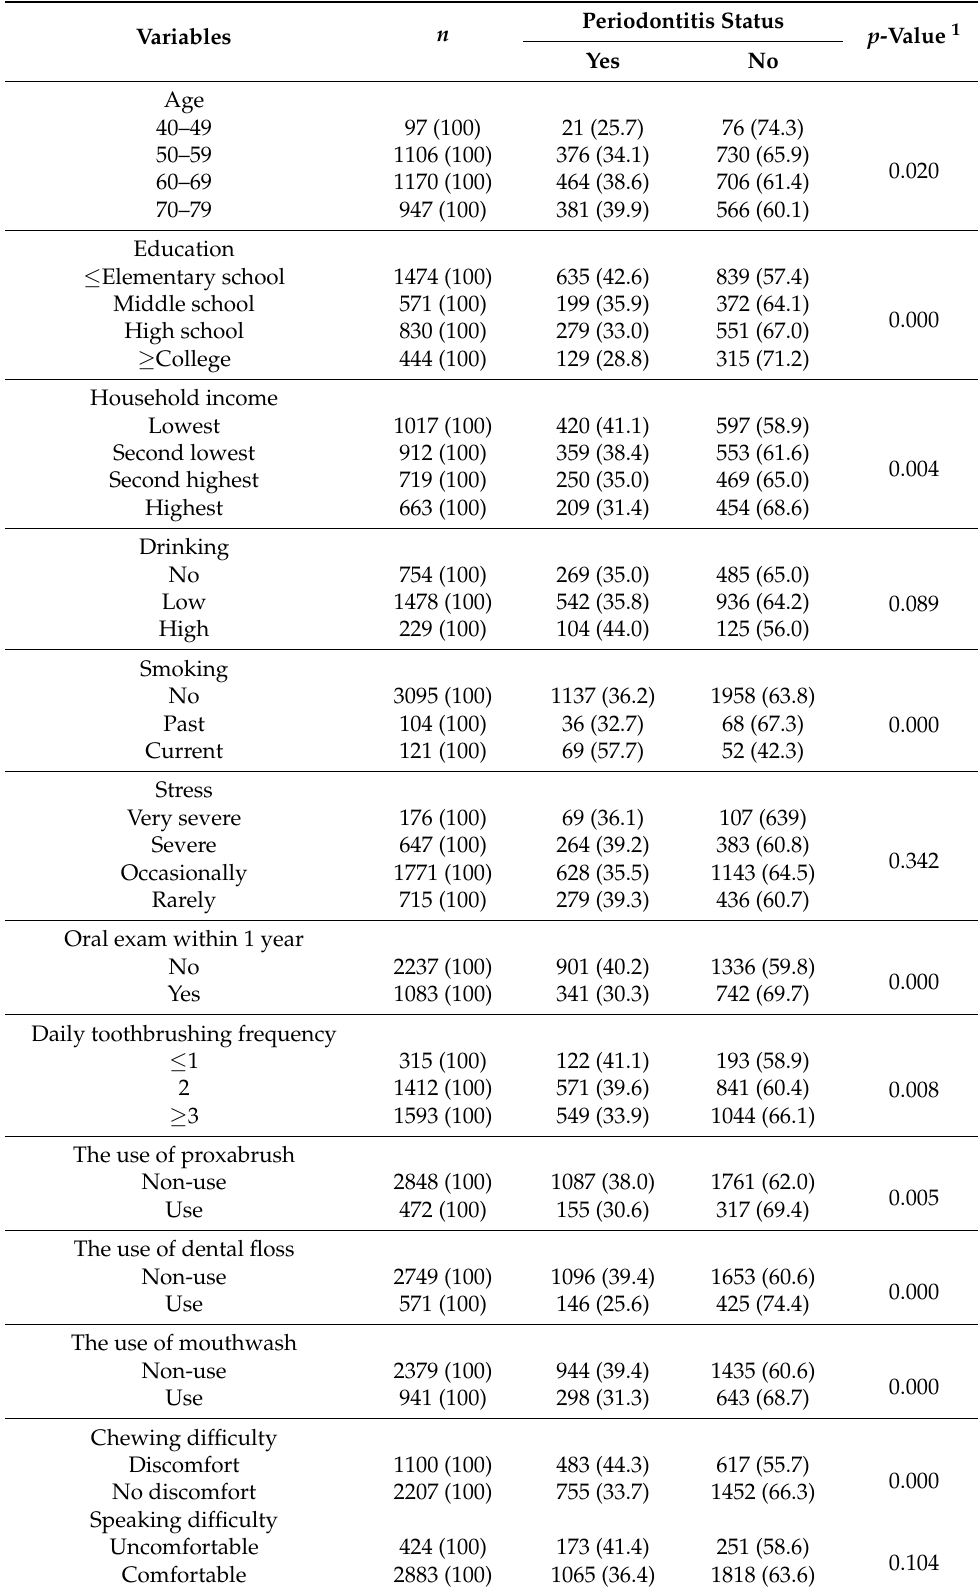
Table 2. Periodontitis according to socio-demographics characteristics and health status and